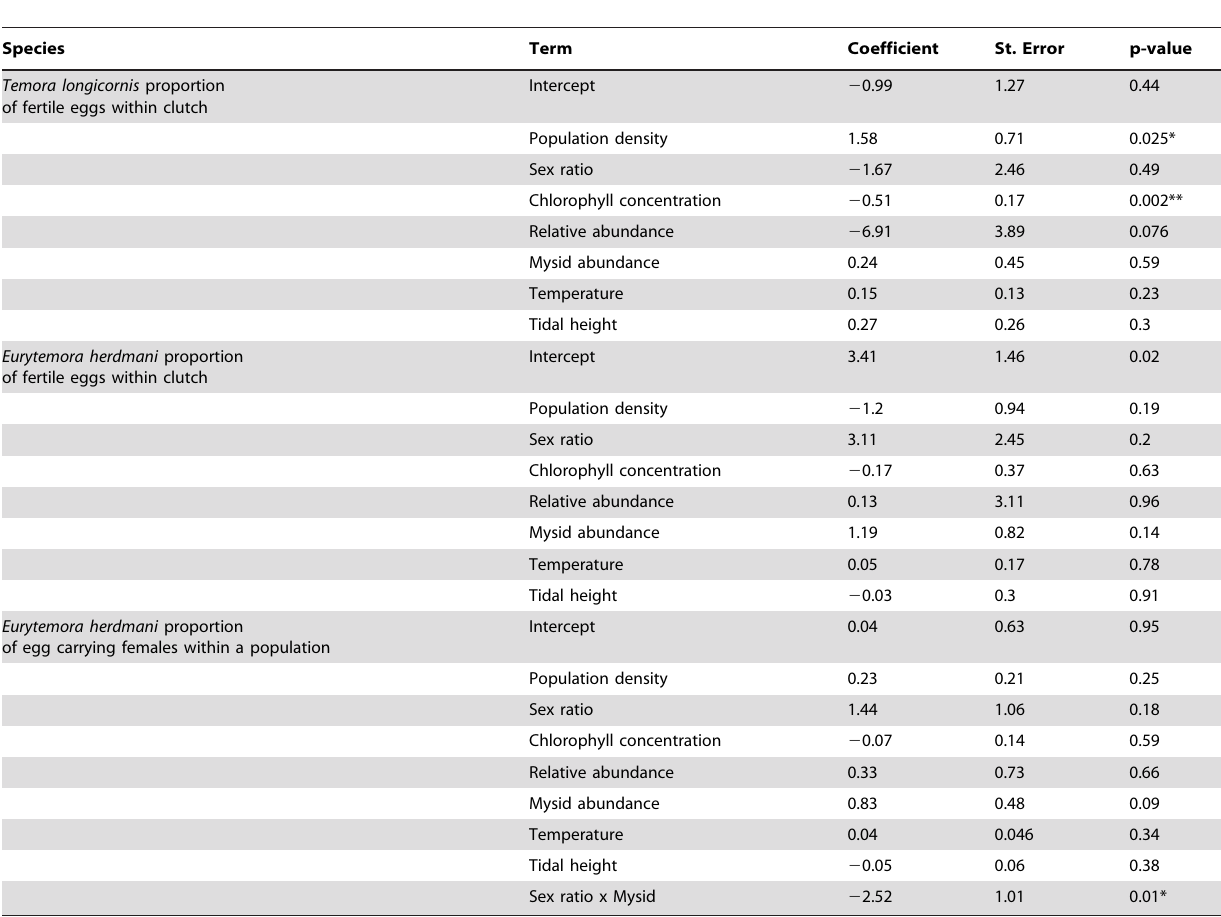
Table 2. Results from generalized linear mixed models (GLMMs) describing factors associated with fertilization in two dominant marine copepod species, Temora longicornis and Eurytemora herdmani.